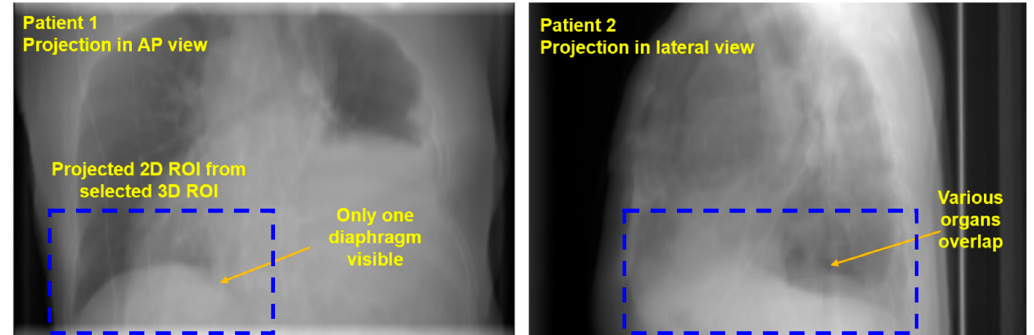
Figure A1. Evaluation of similarity between our DRR images and their corresponding actual X-ray images using dynamic diaphragm phantom data with motion control. ( a ) Representative x-ray projection and pseudo projection (i.e., DRR) images. ( b ) SSIM between X-ray projections of a moving phantom and DRRs of a static phantom for each frame.